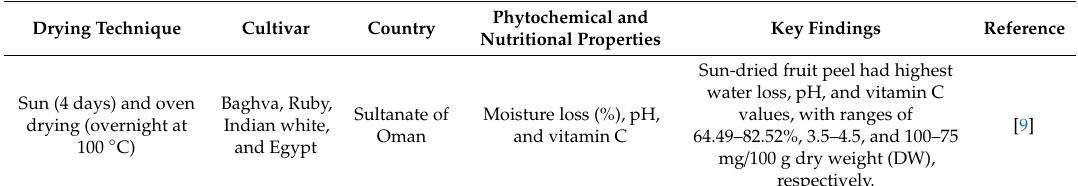
Table 4. The e ff ect of drying techniques on the phytochemical and nutritional properties of pomegranate peel waste.